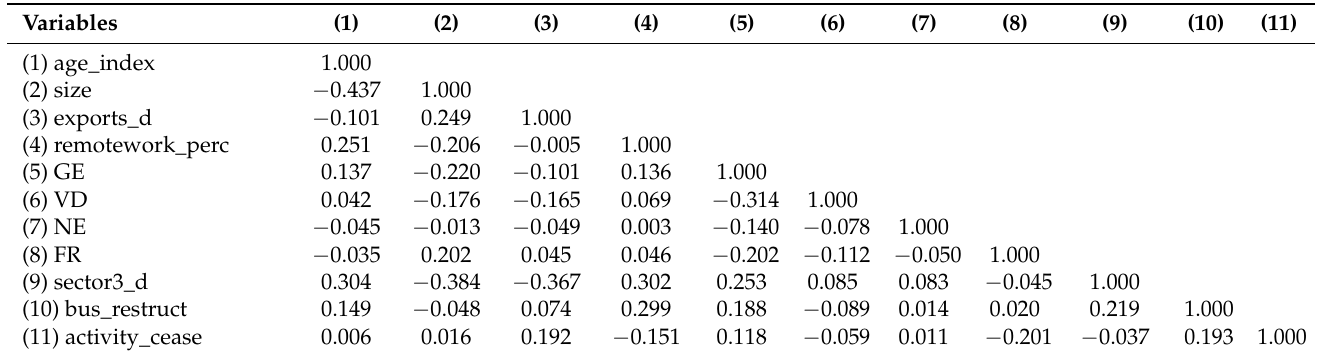
Table 5. Correlation